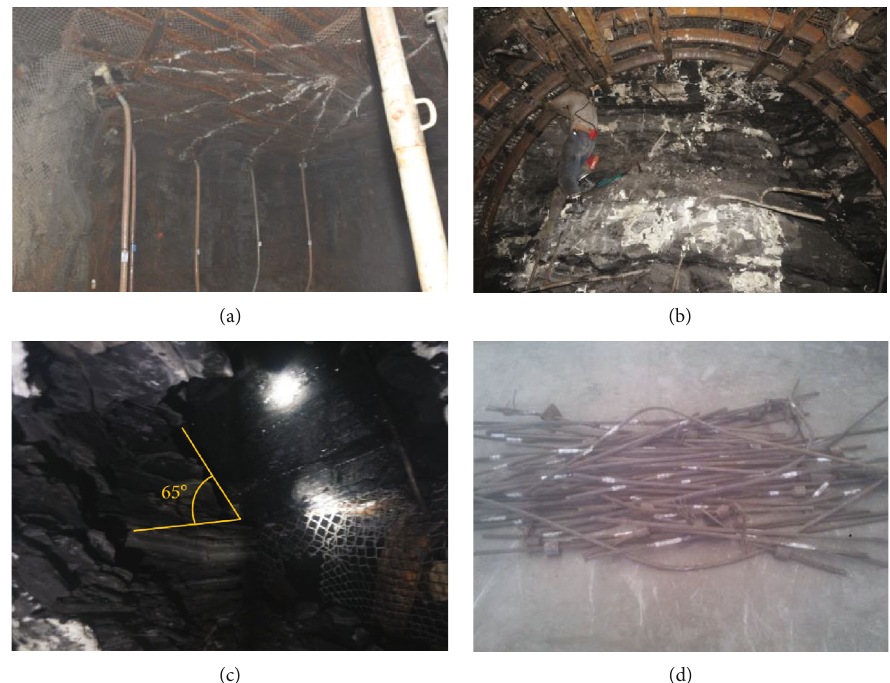
Figure 4: Roof caving accident in Haizi Mine. (a) Water release through drill hole at the roof. (b) Roof caving. (c) Fractured joint surface. (d) Separated anchor bolts and anchor ropes.